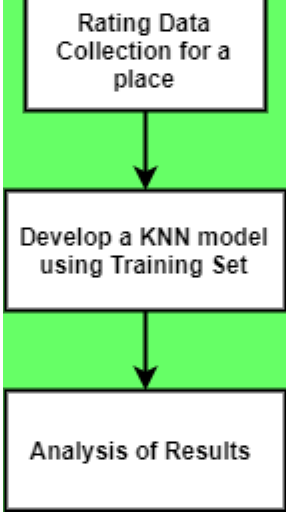
Figure 8. Simulation